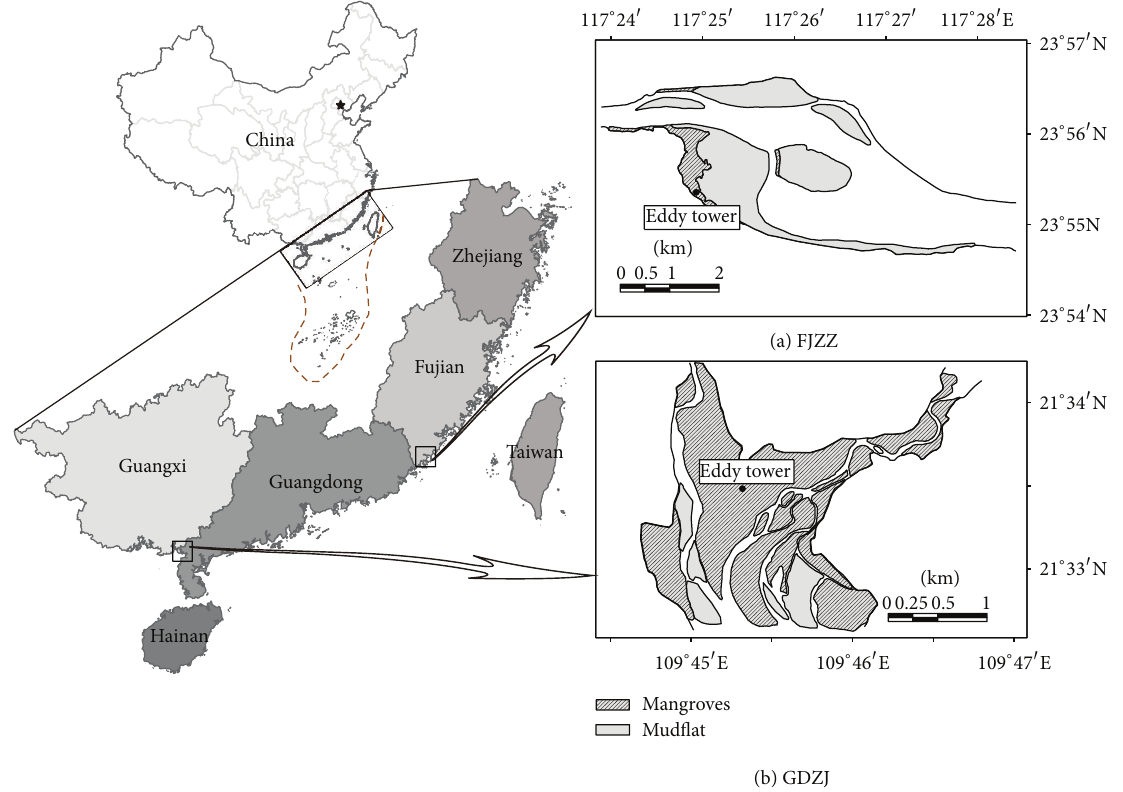
Figure 1: Map for the locations of two study sites of mangrove forests in southern China (FJZZ: Zhangjiangkou Mangrove National Nature Reserve near the Zhangzhou city of Fujian province; GDZJ: Zhanjiang Mangrove National Nature Reserve near the Zhanjiang city of Guangdong